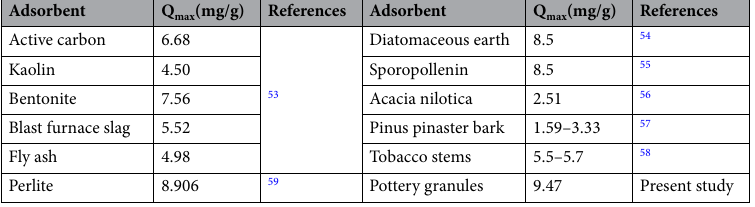
Table 4. Comparison of monolayer adsorption capacity for Pb(II) by different low-cost adsorbents.